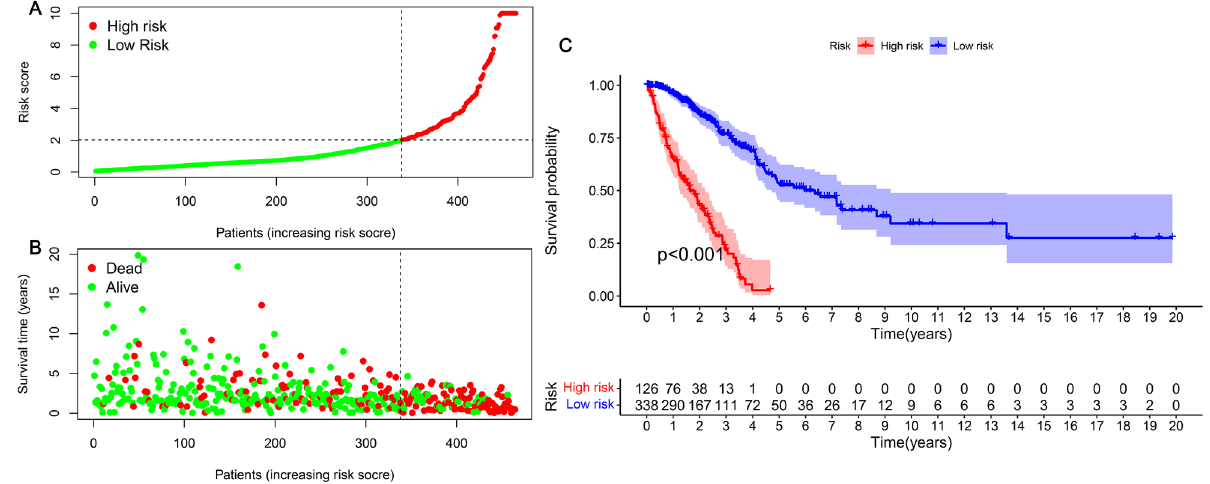
Figure 5. Risk coefficient model for the prognosis anticipation of LUAD. ( A ) To classify patients into low- and high-risk groups, the risk score was utilized. ( B ) Scatter plot of risk score and survival outcome for each patient. ( C ) Construction of the Kaplan–Meier curve on the basis of the survival status of patients belonging to both